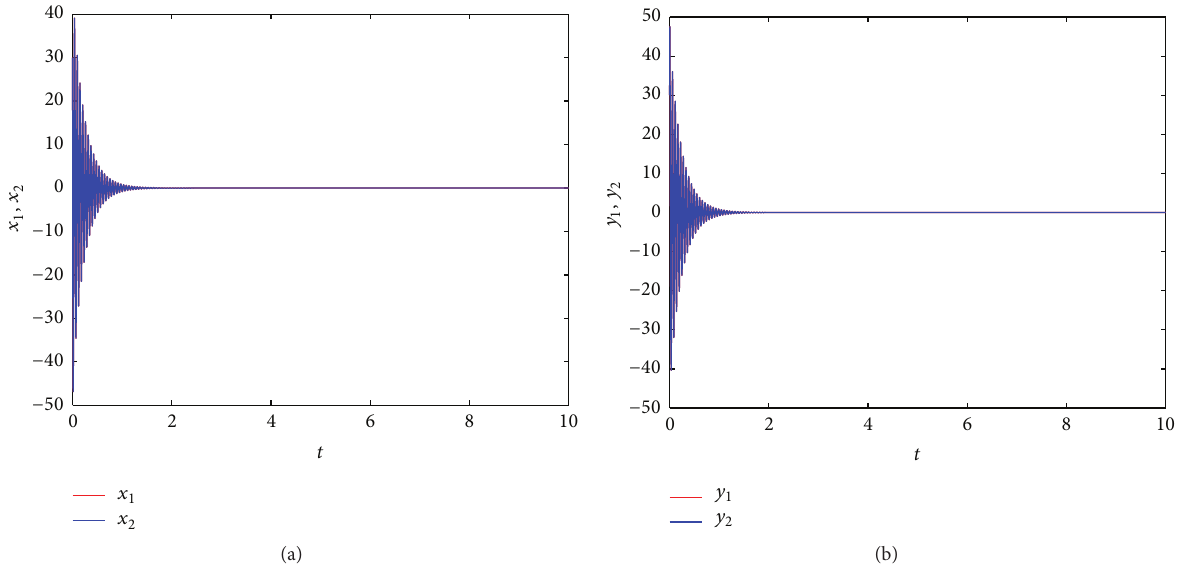
Figure 2: When 𝜏 ∈ [𝜏 − 0 𝜏 + 0 ] , the zero equilibrium is asymptotically stable. 𝑇 = 100 and initial conditions: 30 ⋅ (1,1, 1, 1,1, 1, 1, 1) , 𝜏 = 0.019 .